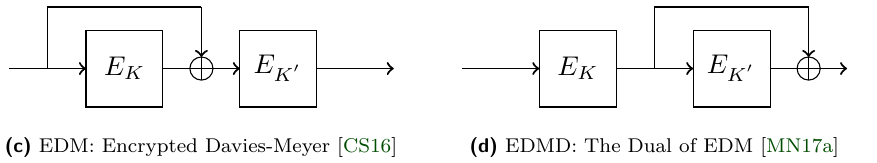
Figure 1: Common PRP-to-PRF conversion schemes, where E K is an n -bit